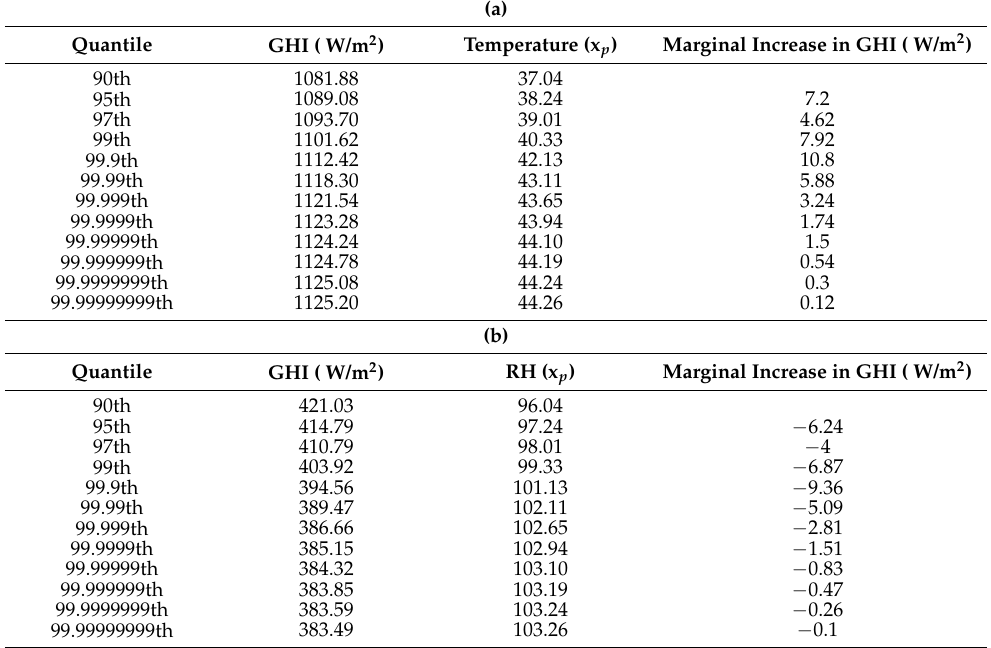
Table 4. ( a ) Estimated quantiles at different tail probabilities and marginal increases in GHI against Temperature. ( b ) Estimated quantiles at different tail probabilities and marginal increases in GHI against RH.